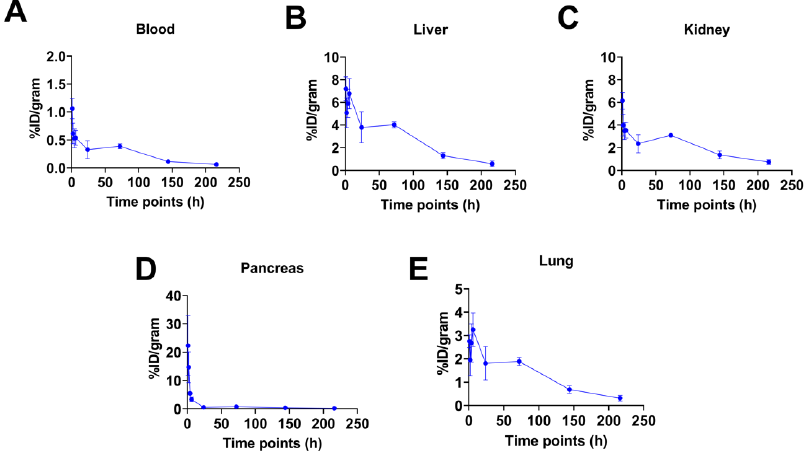
Figure 3. Clearance of [ 67 Cu]Cu-SAR-BBN in selected tissues for C57BL/6 female mice up to 9 days ( n = 5). After intravenous injection with 0.37 MBq radiotracers via tail vein, mice were sacrificed at 1 h, 2 h, 4 h, 6 h, 24 h, 3 days, 6 days, and 9 days. Organs were harvested and counted for activity. The plots focus on the clearance of radiotracer in selected tissues such as blood ( A ), liver ( B ), kidney ( C ), pancreas ( D ), and lung ( E ). Data are expressed as mean ± SD (% ID/g).